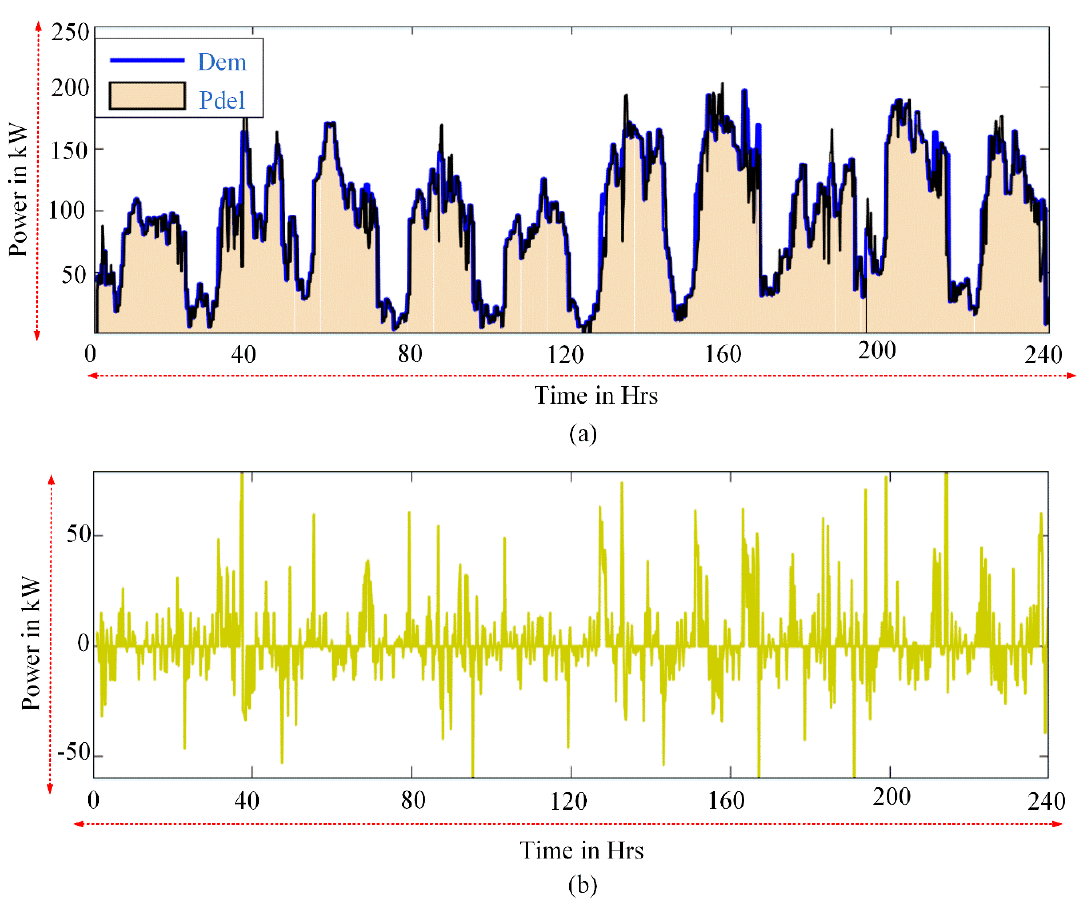
Figure 8. ( a ) Actual Power delivered by the HRES P del plotted against Power Disptach Dem ( b ) Power mismatch Curve ( Pdel – Dem ) .